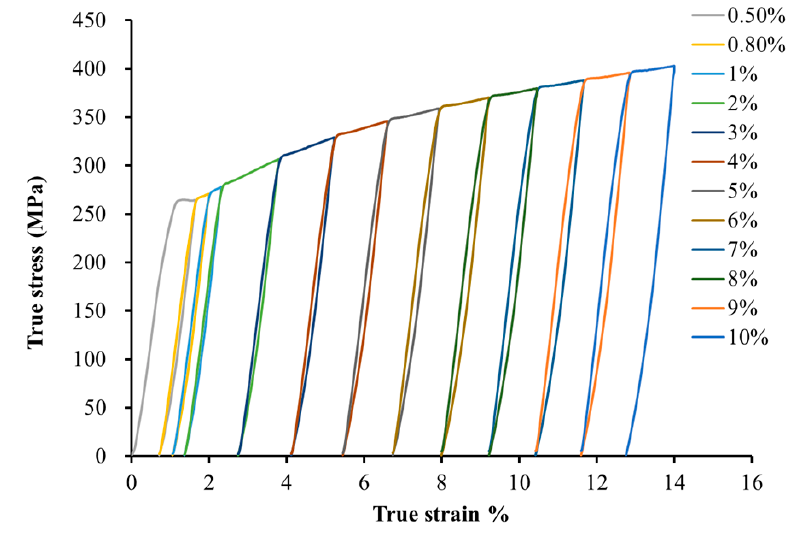
Figure 2. True stress–strain curves of loading–unloading–reloading (LUR) cycle for st-37.